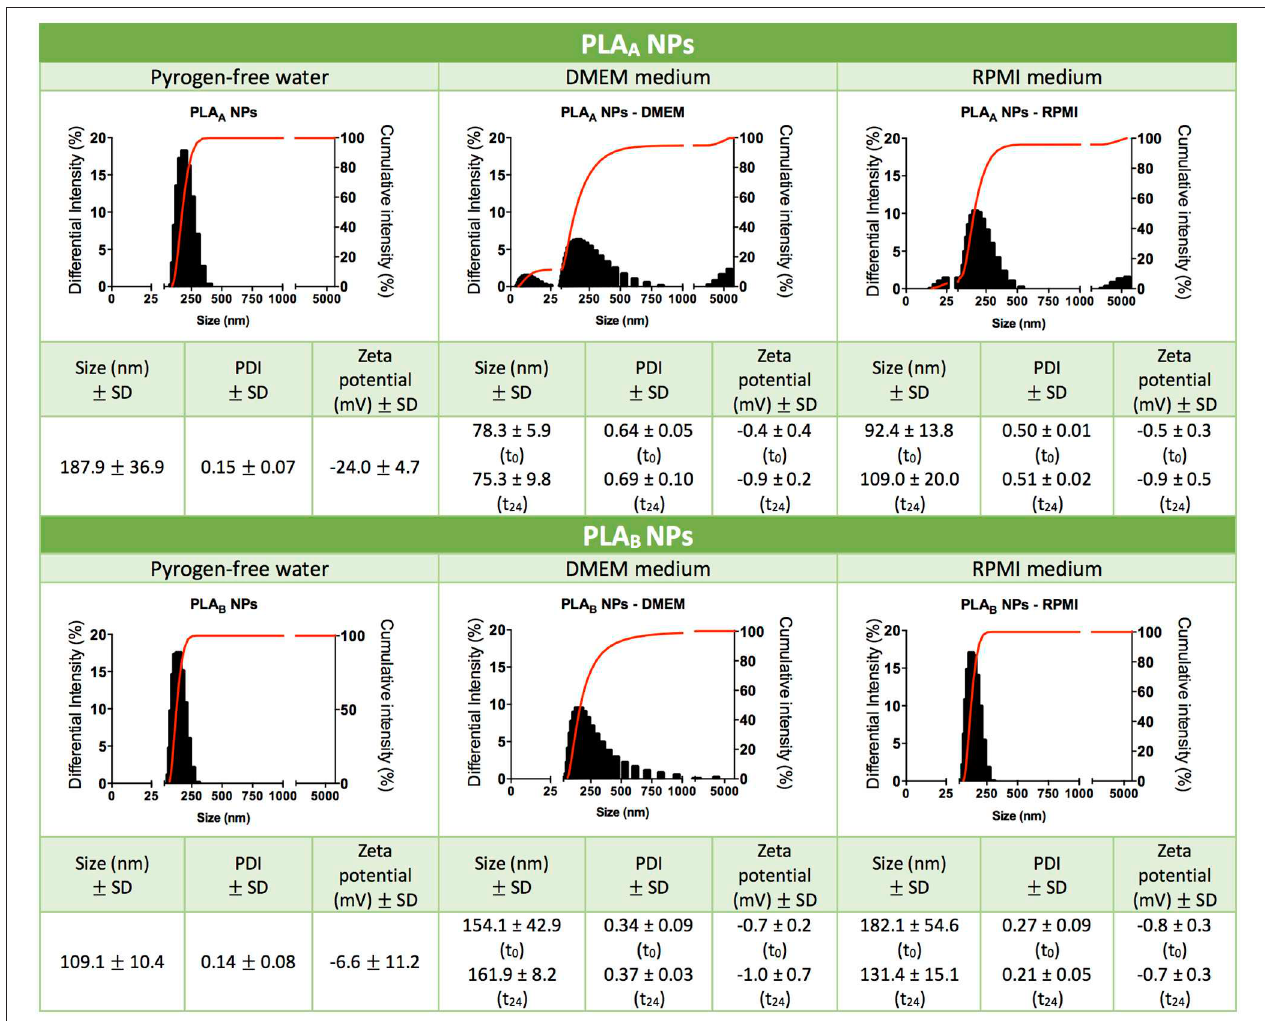
FIGURE 1 | Characterization of PLA NPs. Particle mean size distribution (nm), polydispersity index (PDI), zeta potential (mV) and illustrative graphics of differential and cumulative intensities, after concentration and resuspension in pyrogen-free water, or after 24h of incubation in cell culture media (DMEM medium or RPMI medium). Data are presented as mean ± standard deviation (SD), n ≥ 3 (three or more independent experiments, each in